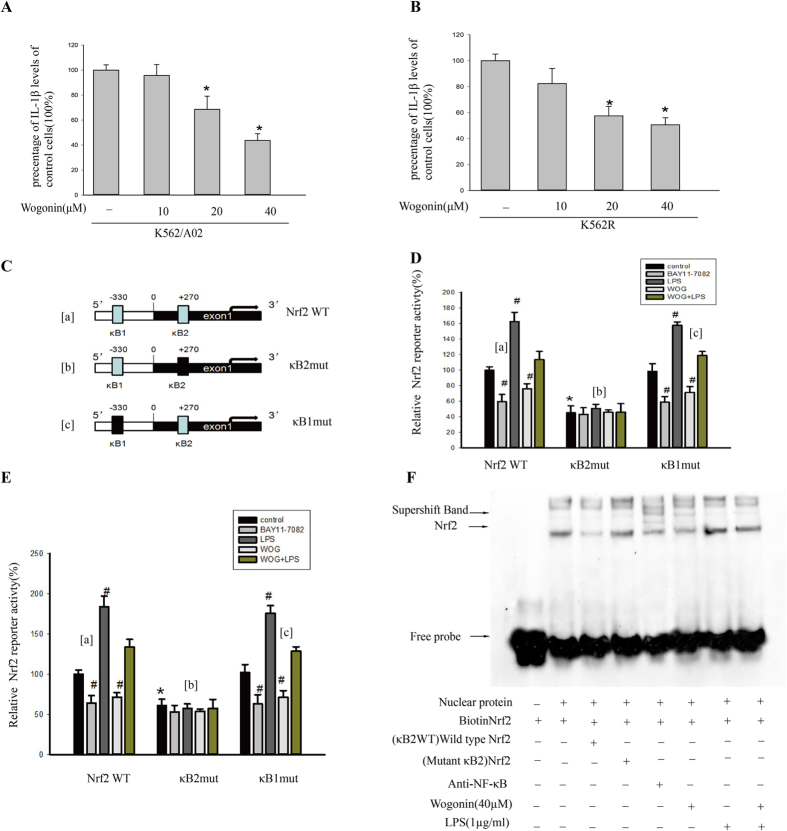
Understanding the regulation of Nrf2 by Wogonin via κB2.(A,B) K562/A02 and K562R cells were treated with various concentrations of Wogonin, and IL-1β secretion was determined by ELISA. *p < 0.05 versus control. (C) Schematic presentation of the Nrf2 promoter constructs that were created for this study, being either wild-type [a], κB2 site-deleted [b], or κB1 site-deleted [c], constructs. (D,E) K562/A02 and K562R cells were transiently transfected with each promoter construct and PGL3 for normalization of transfection efficiency. The supernatant extracts in lysis buffer were harvested, and detected by luciferase assays. *p < 0.05 versus transfected with untreated Nrf2 wild-type control. #p < 0.05 versus untreated controls. LPS (1 μg/ml) treatment acted as a positive control to activate NF-κB and BAY 11-7082 (5 μM) to inhibit NF-κB. (F) The binding of NF-κB subunit p65 to Nrf2 sequence was assessed by EMSA after treatment. Wogonin decreased the p65 binding activity in biotin-Nrf2 probe including κB2 regions alone, and LPS could reverse it. Cold competition probe including mutated κB2 regions no κB1 regions and wild-type Nrf2 probe including normal κB2 regions no κB1 regions. All results were represented as the mean ± SD of three independent experiments.